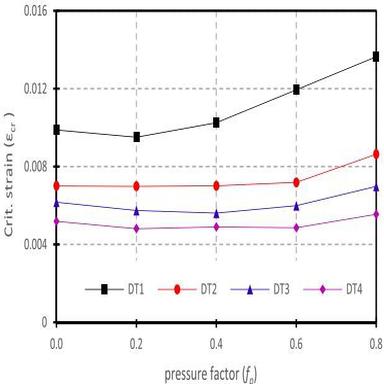
Plot of εcr vs. fp for X52 pipe (YPL = 1.0).